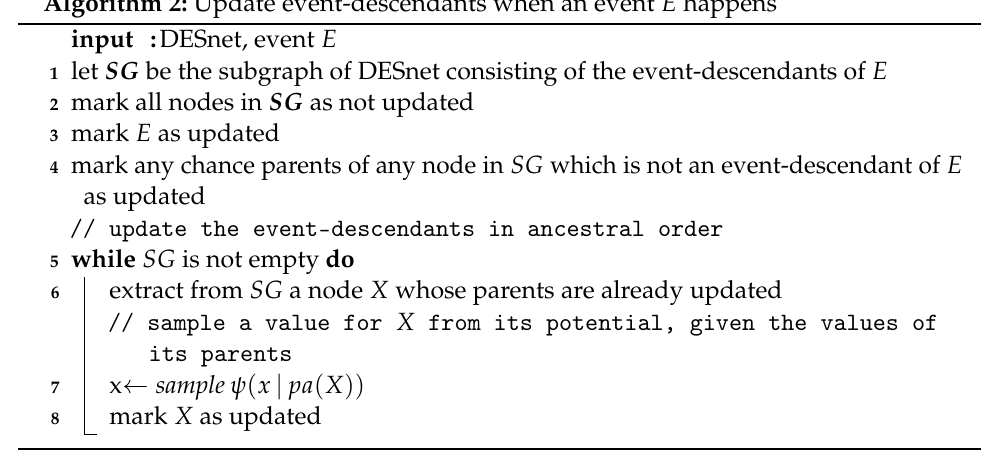
Algorithm 2: Update event-descendants when an event E